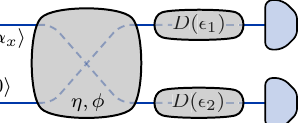
FIG. 3. An optimal receiver for QPSK discrimination. The unknown coherent state is first mixed with a vacuum state at a beam splitter (BS) with transmissivity η and phase φ . Each mode is then independently displaced in phase space by (cid:8) 1 , (cid:8) 2 , before being detected using bucket detectors. This scheme is easy to implement given its independence of ancillary states and adaptive strategies.